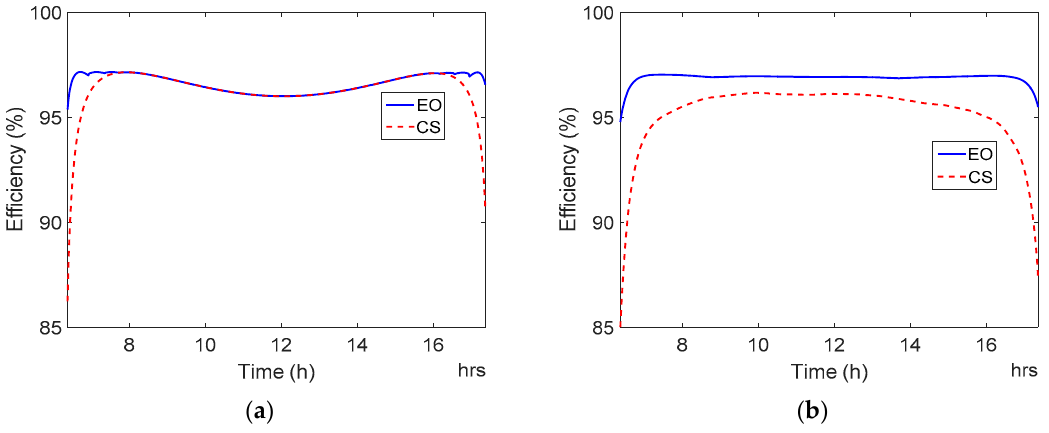
Figure 18. Daily efficiency curves of Power-One ULTRA-750-TL-OUTD-4-US with average current- Figure 18. Daily e ffi ciency curves of Power-One ULTRA-750-TL-OUTD-4-US with average sharing control method ( CS ) and efficiency-oriented method ( EO ). ( a ) Sunny day. ( b ) Cloudy day. current-sharing control method ( CS ) and e ffi ciency-oriented method ( EO ). ( a ) Sunny day. ( b ) Cloudy